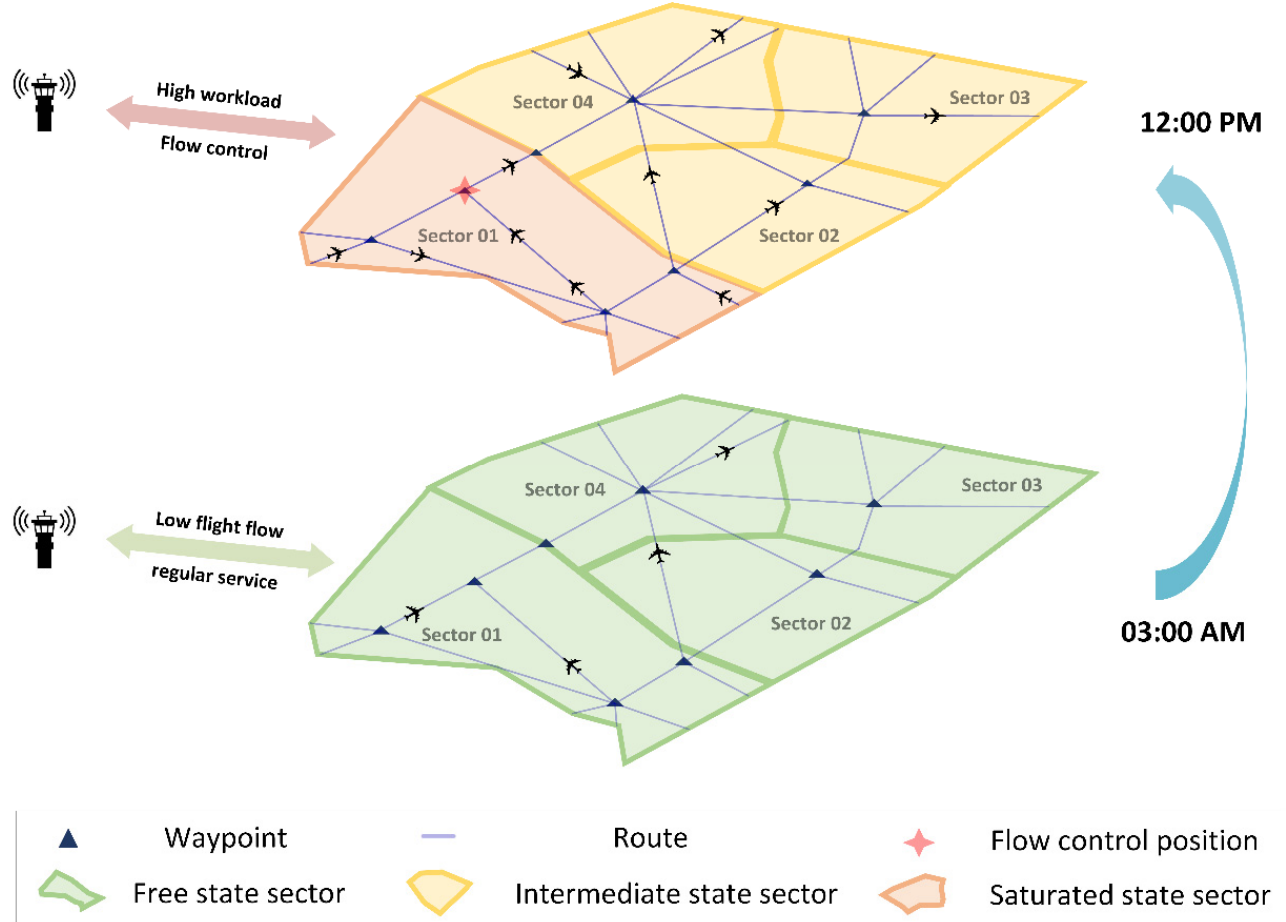
Figure 1. The air traffic situation of the four control sectors in the Shanghai control area at different times.